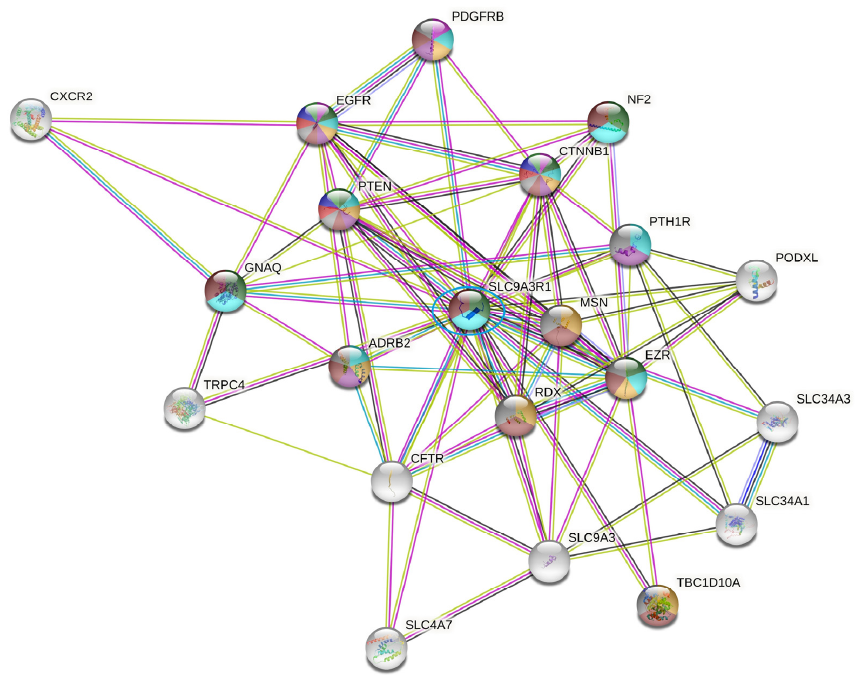
Figure 3. Network of interactions among SLC9A3R1 proteins by STRING software. The colored balls represent proteins related to the estrogen pathway. Associations were visualized with a medium confidence cutoff (0.400).